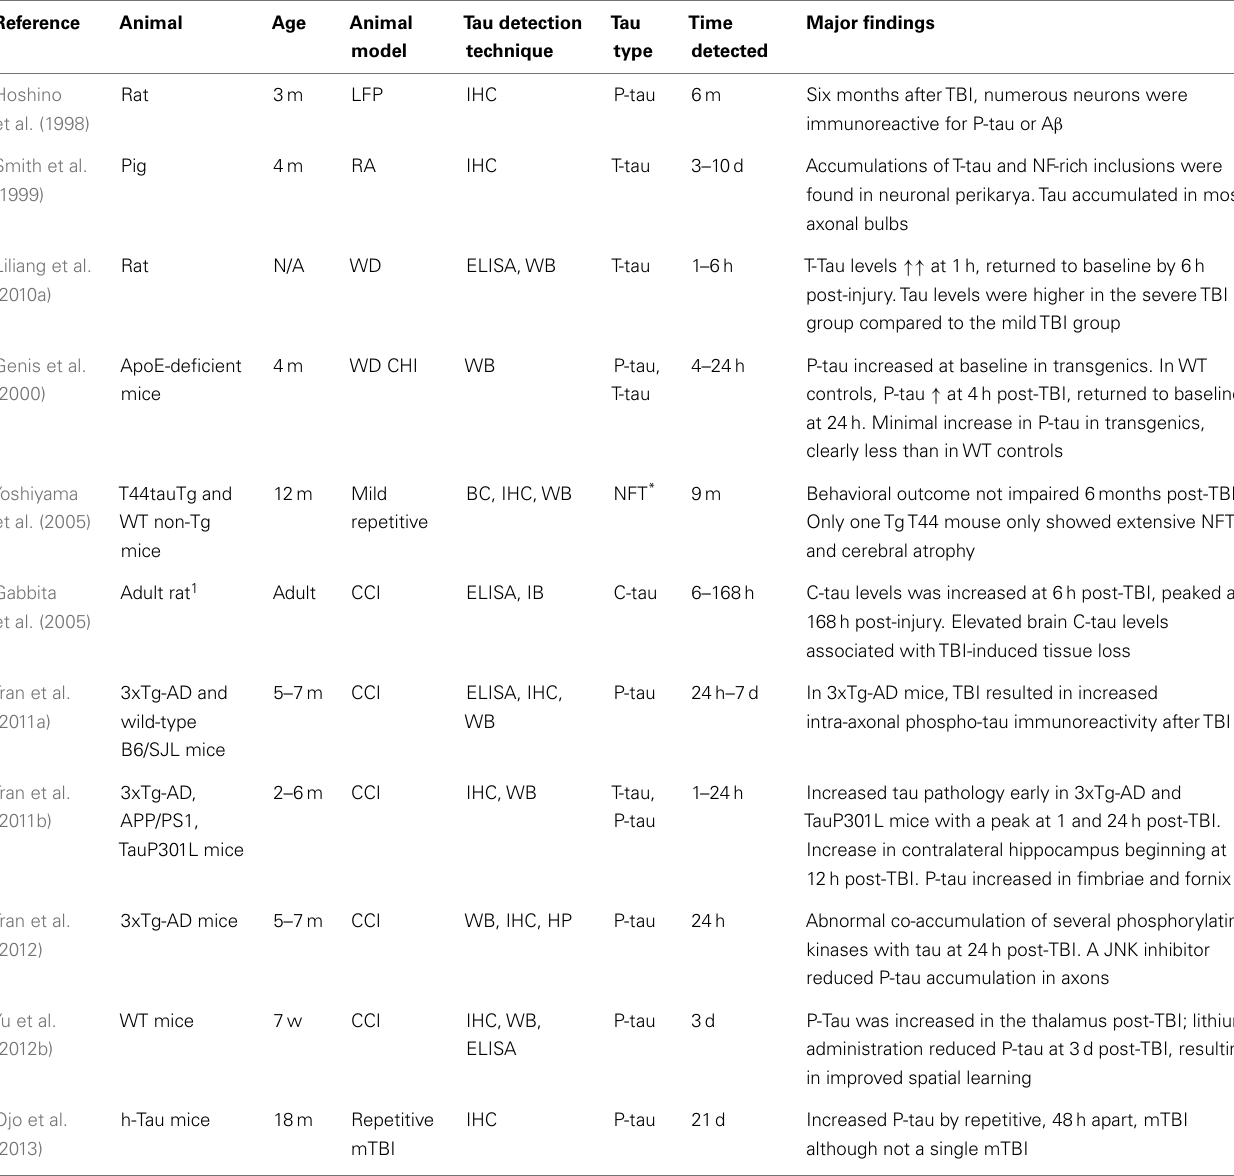
Table 2 |Animal studies on traumatic brain injury (TBI) and